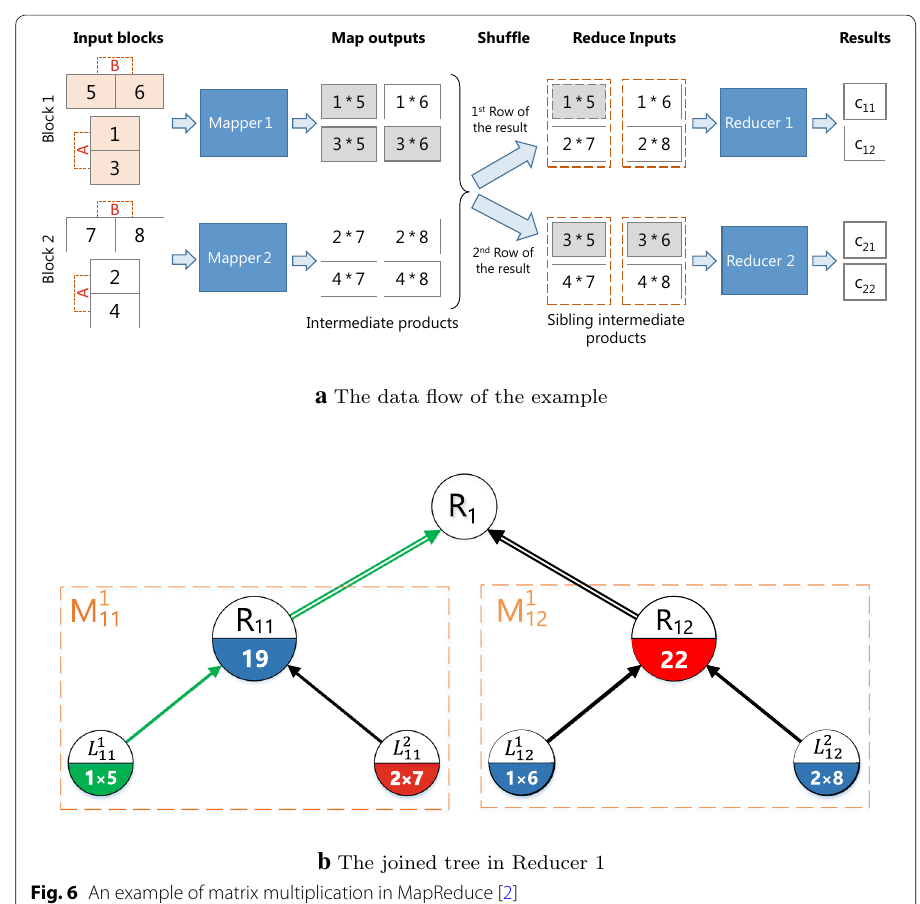
Fig. 6 An example of matrix multiplication in MapReduce